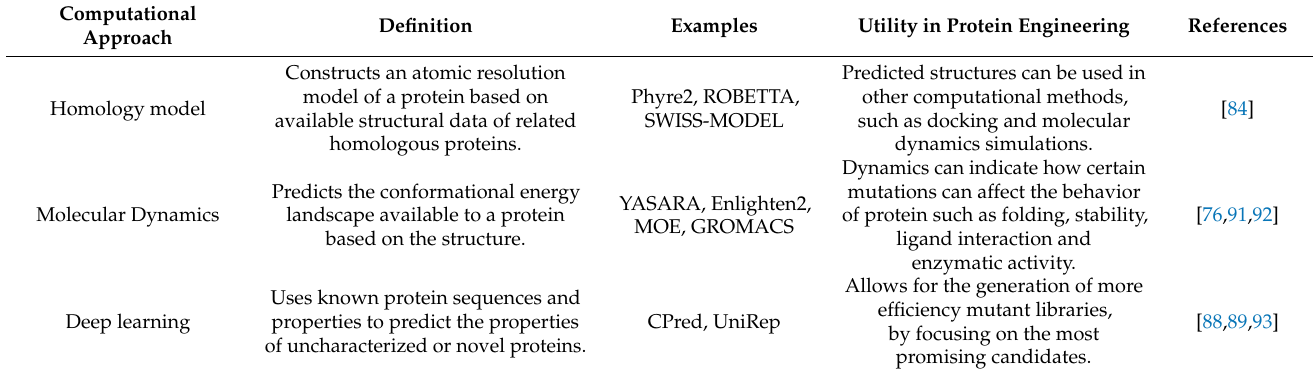
Table 4. Example of computational approaches used in protein